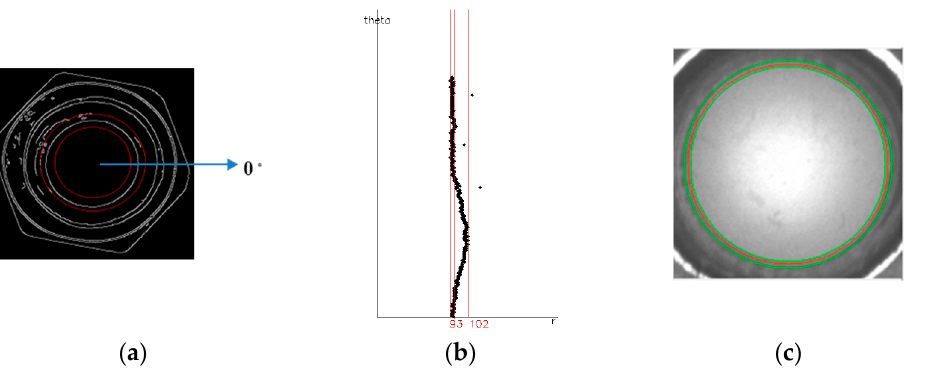
Figure 10. Calculating the distance between the angles of the center and the inner holes of a circle: ( a ) Search range; ( b ) D 0 ~D 359, the red line represents the minimum distance from the center point, the average distance from the center point, and the maximum distance from the center point; ( c ). Roundness.